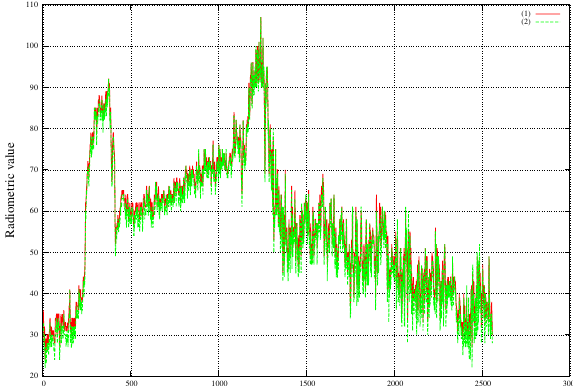
Figure 15. Radiometric profil of the first image (red) and the stacked image (green).